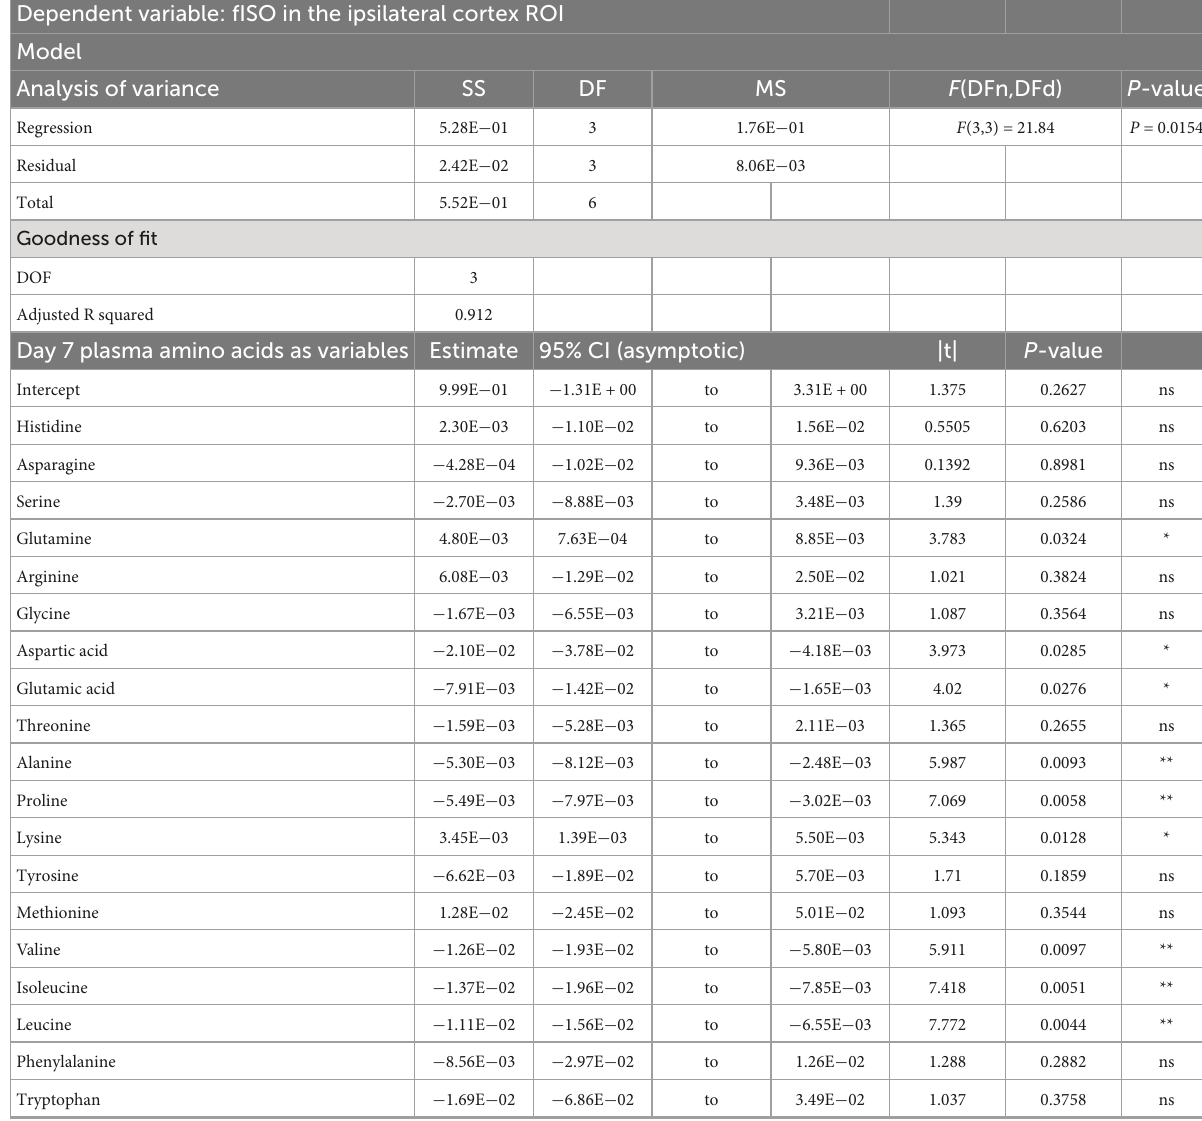
TABLE 3 Result of PCR predicting the fISO quantified from the ipsilateral cortex ROI from the plasma amino acid panel at day seven post-injury. Dependent variable: fISO in the ipsilateral cortex ROI Model Analysis of